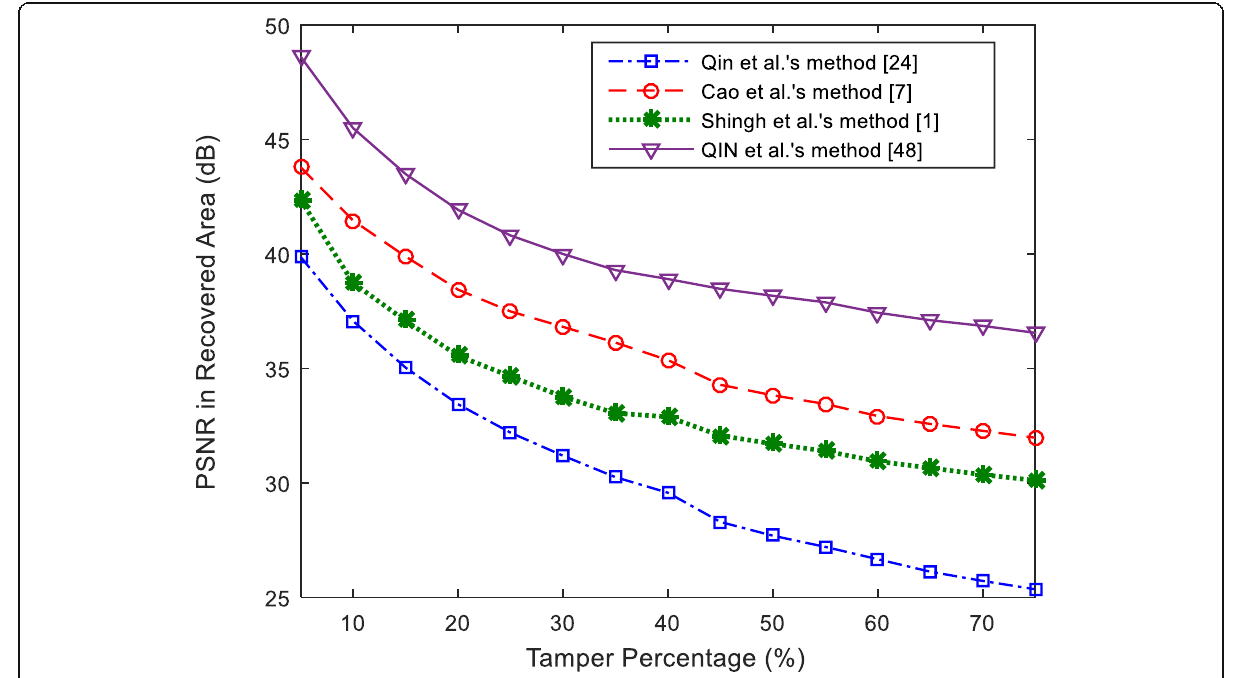
Fig. 19 Performance comparison on average PSNR of three images versus tamper cropping attacks percentage